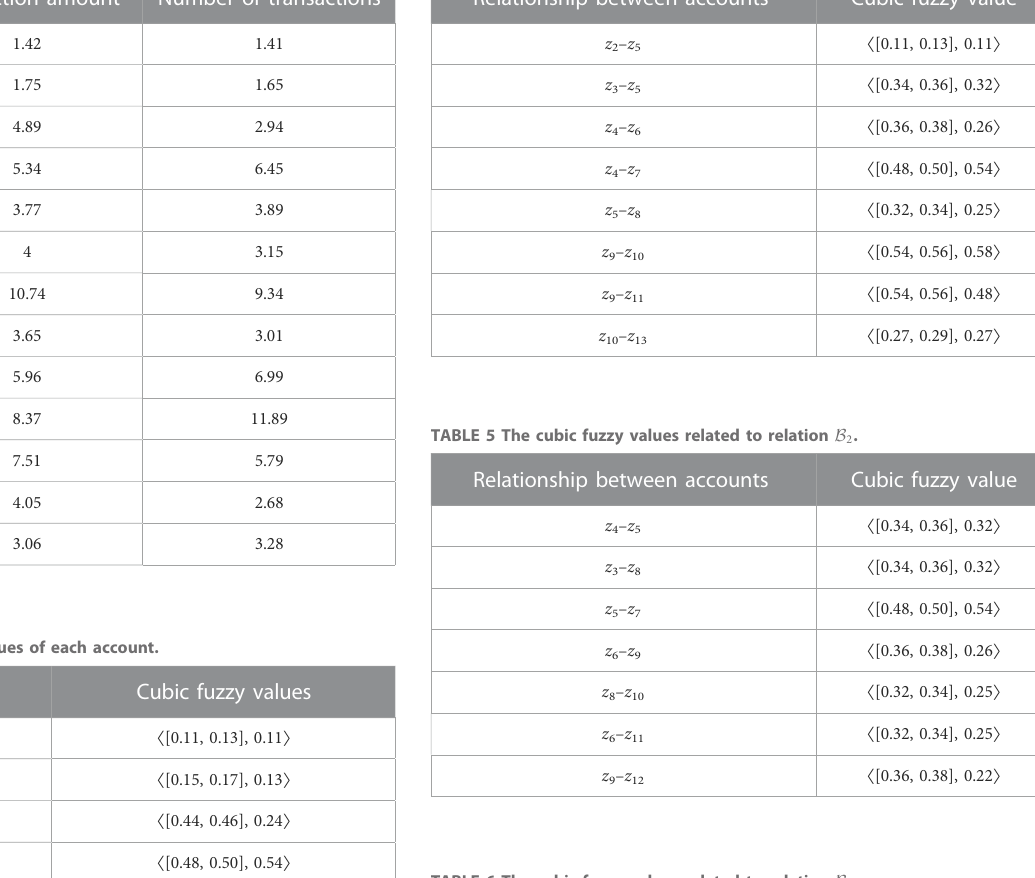
TABLE 6 The cubic fuzzy values related to relation B